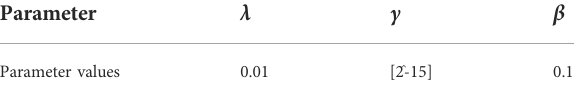
TABLE 3 Values of parameters α , μ , γ of the GHKNN classi fi er. Parameter Parameter values